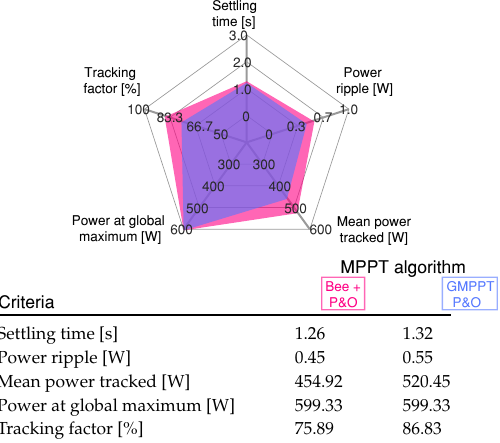
Figure 8. Comparative analysis of the MPPT methods for Scenario 1 shown in Figure 7.